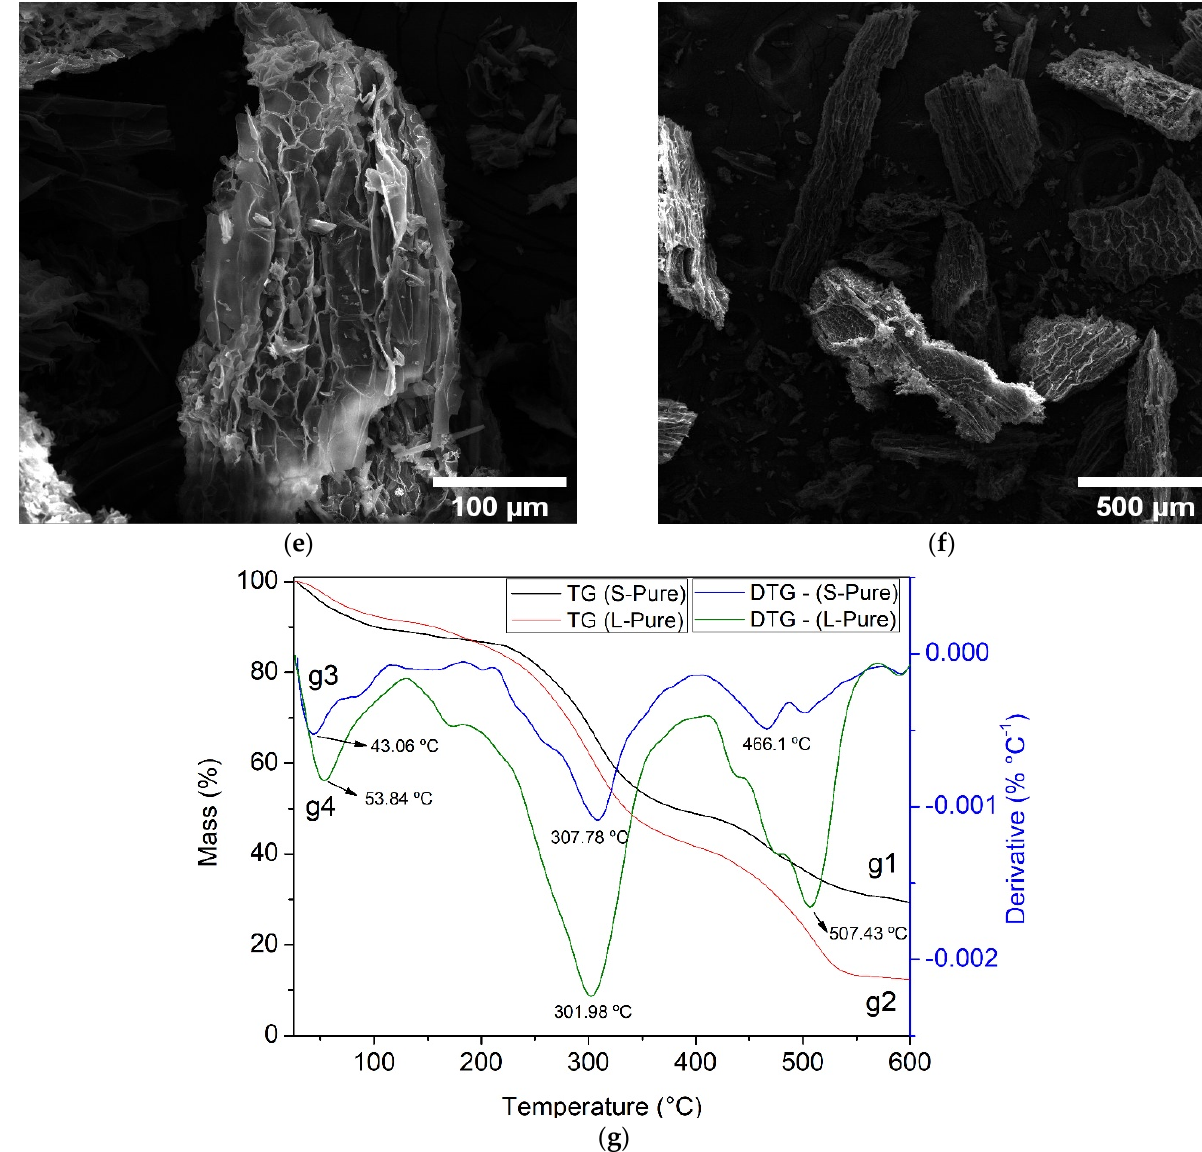
Figure 1. ( a ) X-ray diffractograms of the water hyacinth biomass: (a1) stem and (a2) leaf of; ( b ) FTIR spectra of (b1) stem and (b2) leaf; SEM—micrograph of the water hyacinth parts: ( c , d ) stem; ( e , f ) leaf. ( g ) TG thermogravimetric curves of water hyacinth (g1) stem and (g2) leaf. DTG: water hyacinth (g3) stem and (g4) leaf.